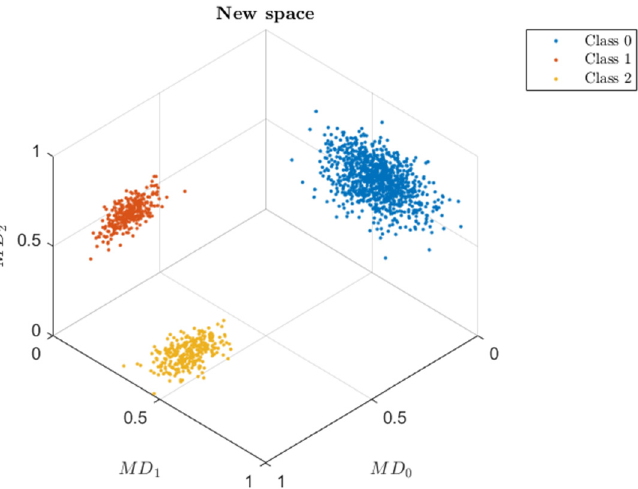
Figure 5. Two-dimensional exemplary representation of the multivariate initial space of three approximately equally spaced clusters ( left ). Representation and trend of the Mahalanobis distances of the same points ( right ). The graphs show the MDs calculated with respect to each cluster.